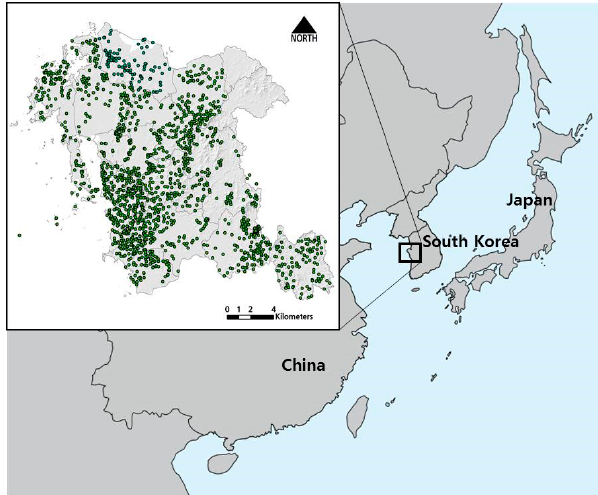
Figure 1. Sampling sites in Chungcheongnam Province.